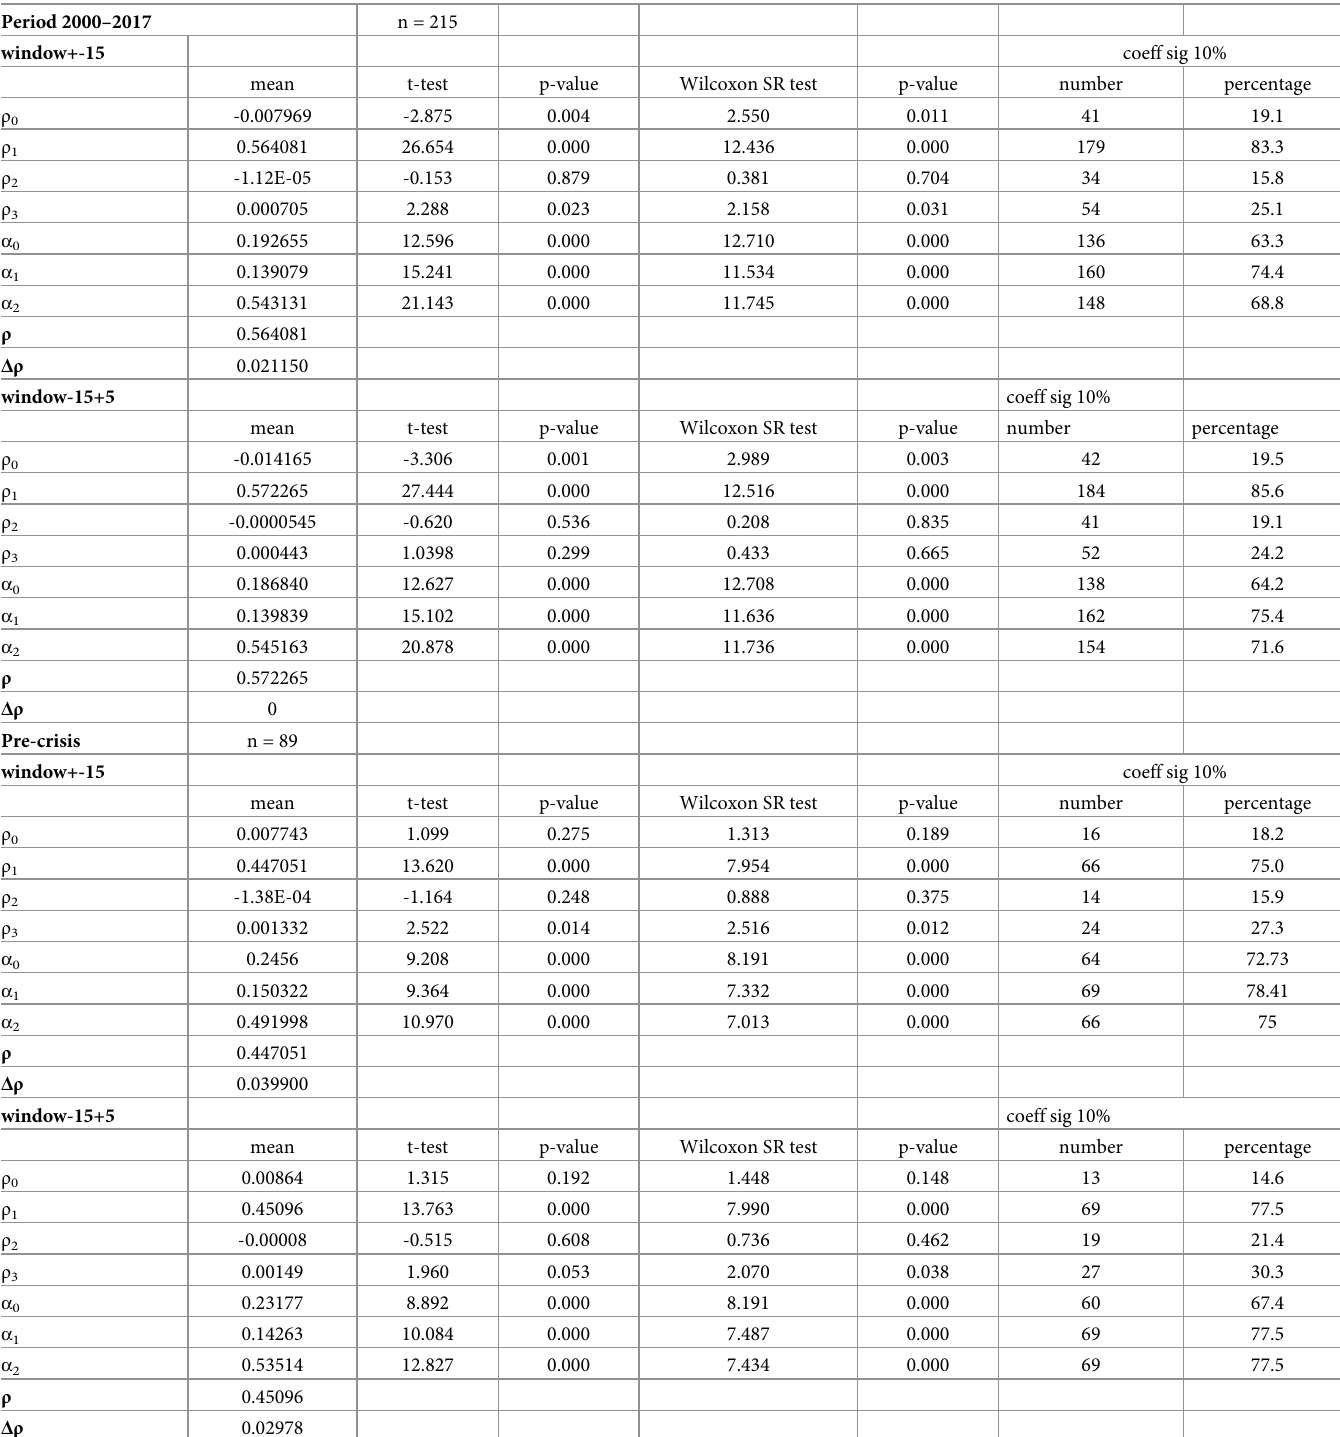
Table 12. Summary results–normalized: